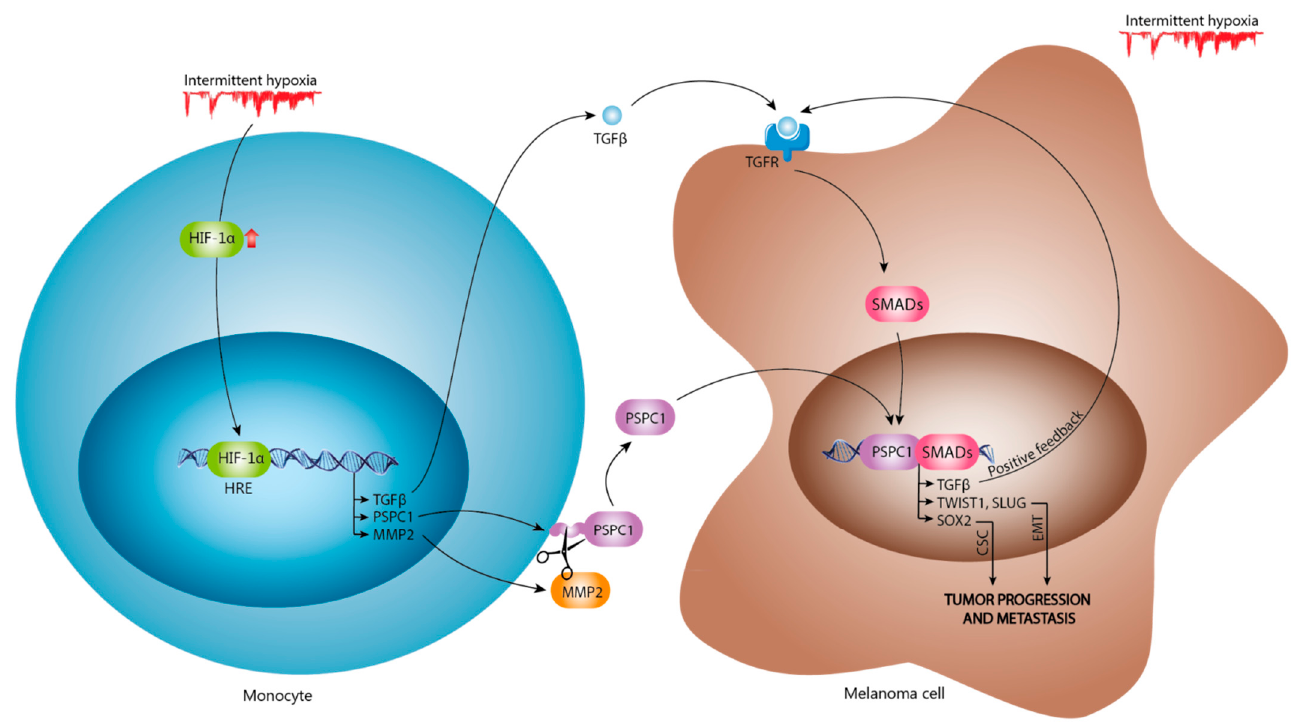
Figure 6. PSPC1 expression in patients with OSA increases TGF β expression effect on EMT-TFs. Intermittent hypoxia increases the activation of HIF1 α , which might bind with the promoter of genes such as PSPC1, MMP2, and TGF β , leading to high levels of these proteins in severe OSA monocytes. The MMP2 plays a role in PSPC1 cleavage, increasing plasma PSPC1 levels. The combination of high plasma levels of TGF β and PSPC1 increases the EMT-TF effect through TWIST and SLUG and CSC effect by SOX2 in melanoma cells.